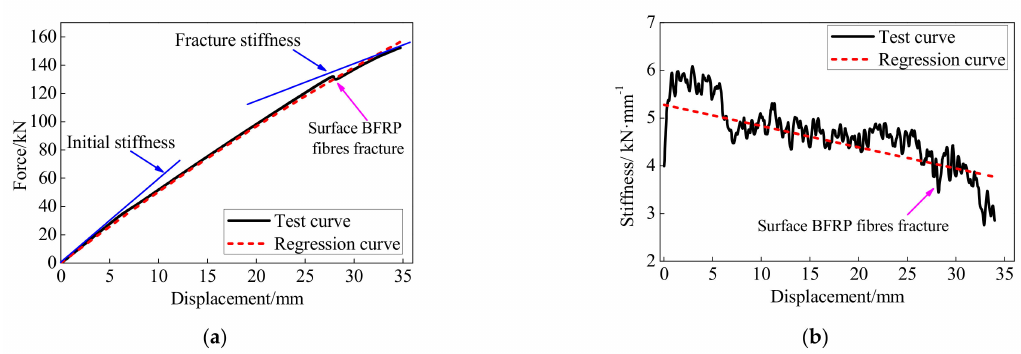
Figure 7. Comparison of the test and calculation results: ( a ) force-displacement curve; ( b ) stiffness.